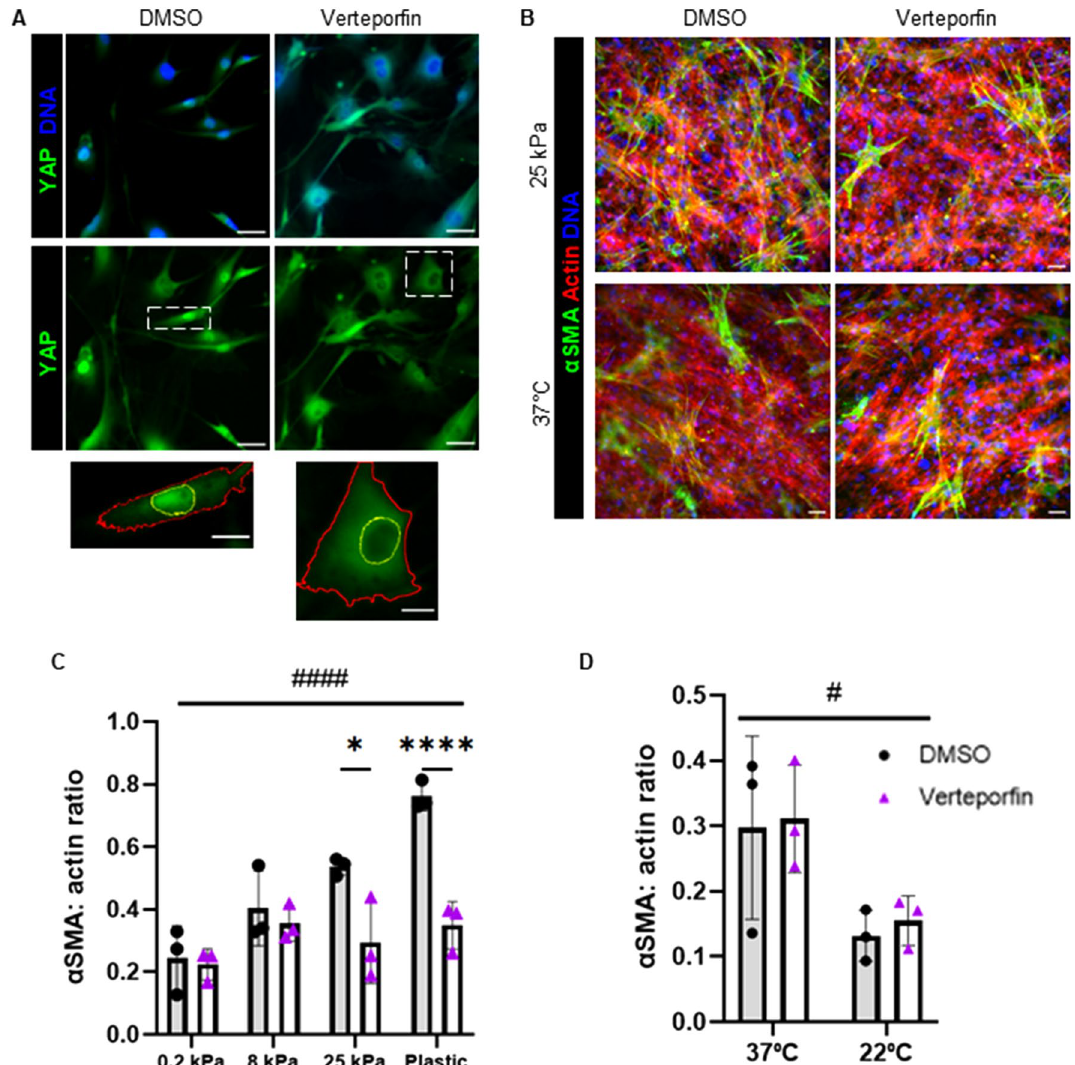
Figure 7. Yap inhibition reduces myofibroblast activation. ( A ) YAP localization in FAPs cultured on plastic in DMSO or 0.5 µM verteporfin for 2 days. Scale bars are 50 µm, insets are 20 µm. Yellow outlines indicate nuclei and red outlines indicate cytoplasm on insets. ( B ) Myofibroblast activation in FAPs cultured for 7 days with 0.5 µM verteporfin or 0.1% DMSO on collagen-coated polyacrylamide gels at 25 kPa and 3.0 mg/ml telocollagen gels polymerized at 37 °C. Scale bars set to 50 µm. ( C ) Quantification of myofibroblast activation of FAPs in DMSO or 0.5 µM verteporfin on collagen-coated polyacrylamide gels. ( D ) Quantification of myofibroblast activation of FAPs in DMSO or 0.5 µM verteporfin on collagen gels polymerized at different temperatures. * P < 0.05, **** P < 0.0001 between DMSO and verteporfin treatment. # P < 0.05, #### P < 0.0001 between